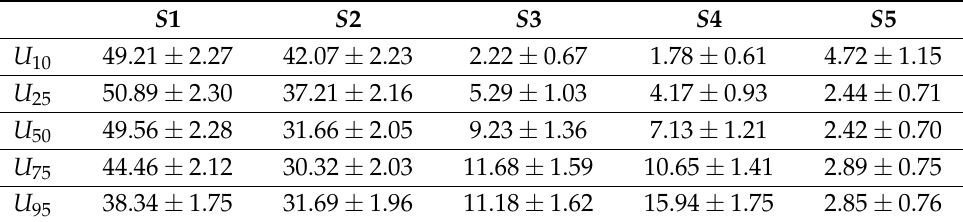
Table 5. The average scheduling percentages of every charging/discharging decision with different global uncertainty